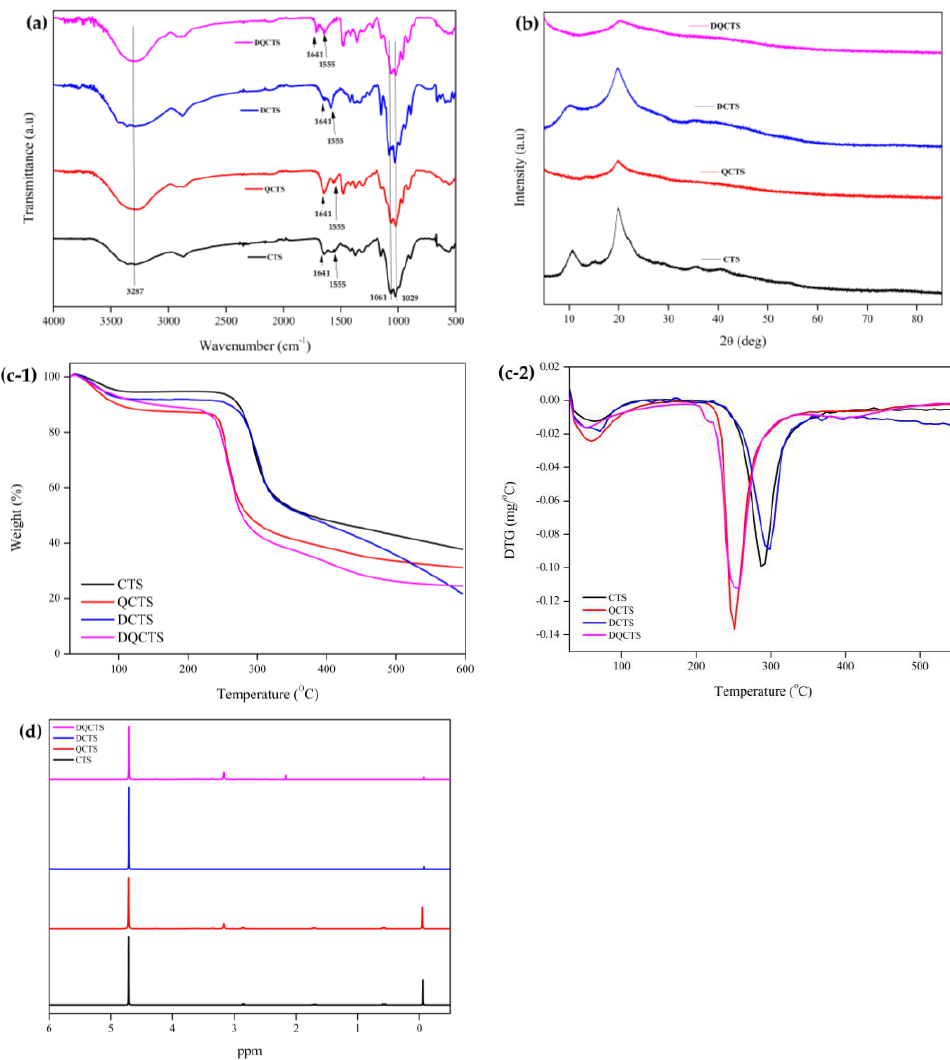
Figure 1. ( a ) FT-IR, ( b ) XRD pattern, ( c ) TGA ( c - 1 ) and DTG ( c-2 ) thermograms, and ( d ) NMR of chitosan compounds. CTS: chitosan, QCTS: quaternized chitosan, DCTS: fully deacetylated chitosan, DQCTS: fully deacetylated quaternized chitosan.